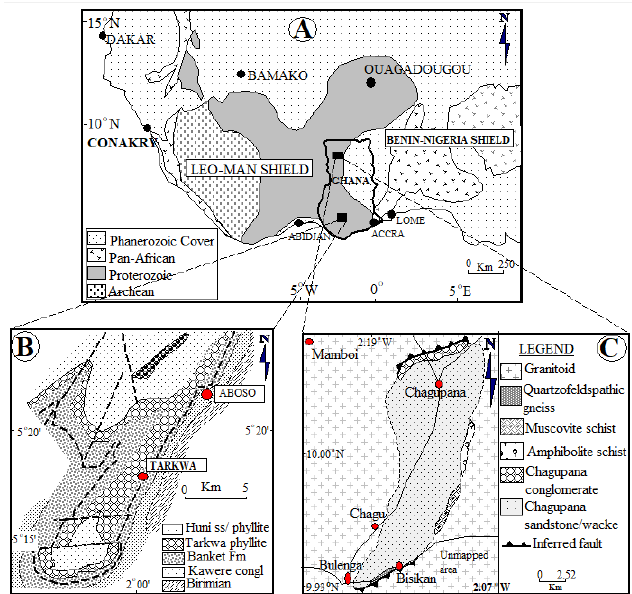
Figure 1: (A) The Leo-Man shield showing the Tarkwa and Chagupana areas (Feybesse et al., 2006); (B) Tarkwaian in Tarkwa (Davis et al., 1994); (C) The Chagupana (Ch) sedimentary basin (study area) (Block et al., 2015).